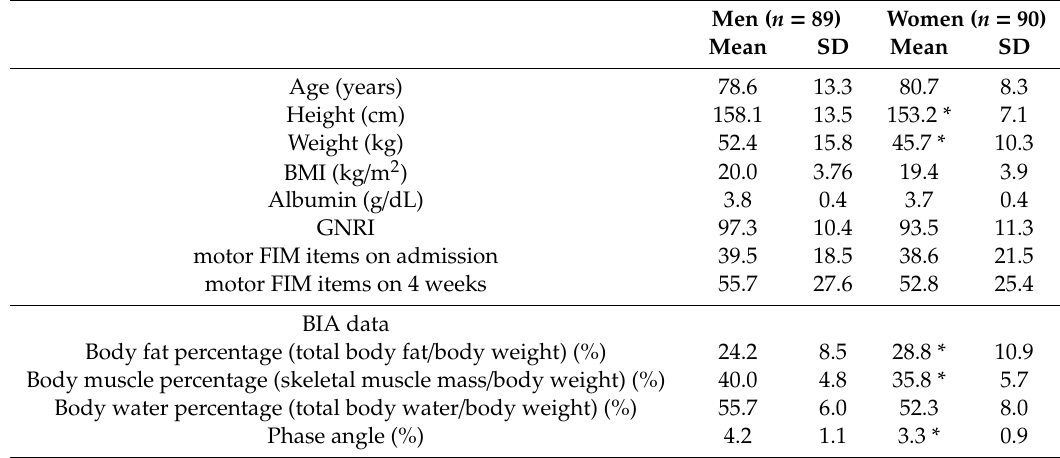
Table 2. Characteristics of patients according to sex.